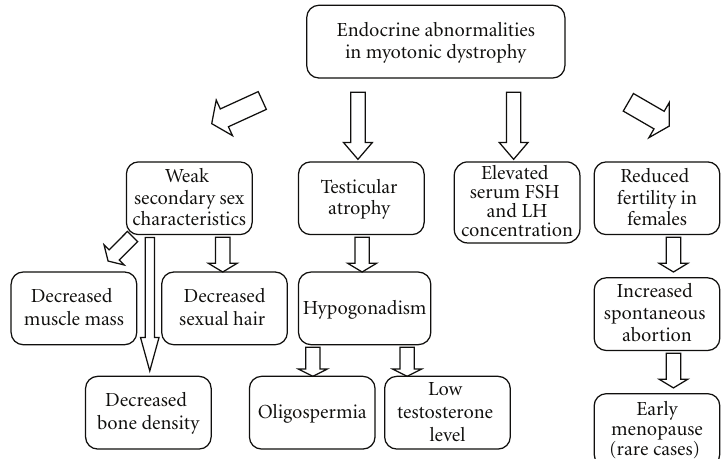
Figure 4: Endocrine abnormalities described in